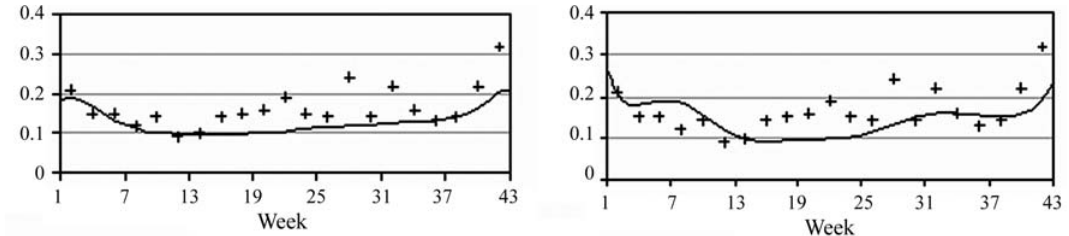
Figure 3 - Heritability estimates by 4,6,vf6 (left) and 6,6,vf6 (right) random regression and standard univariate analysis